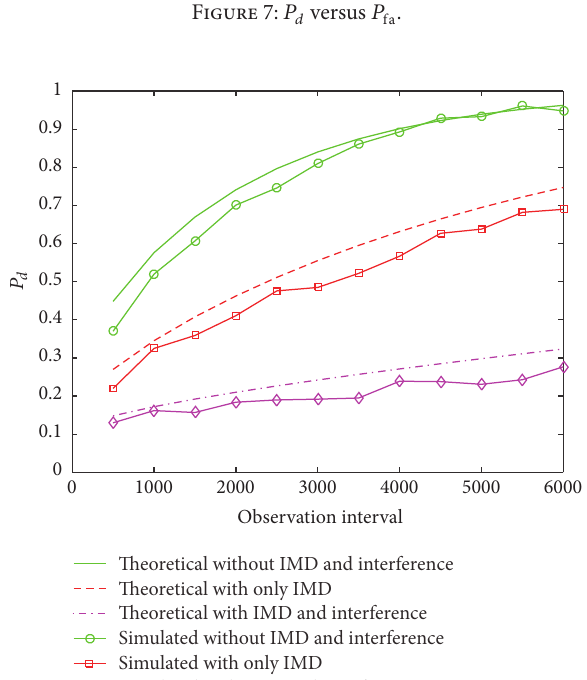
Figure 8: Effect of sensing time on the performance of ED at 𝑃 fa = 0.1 .